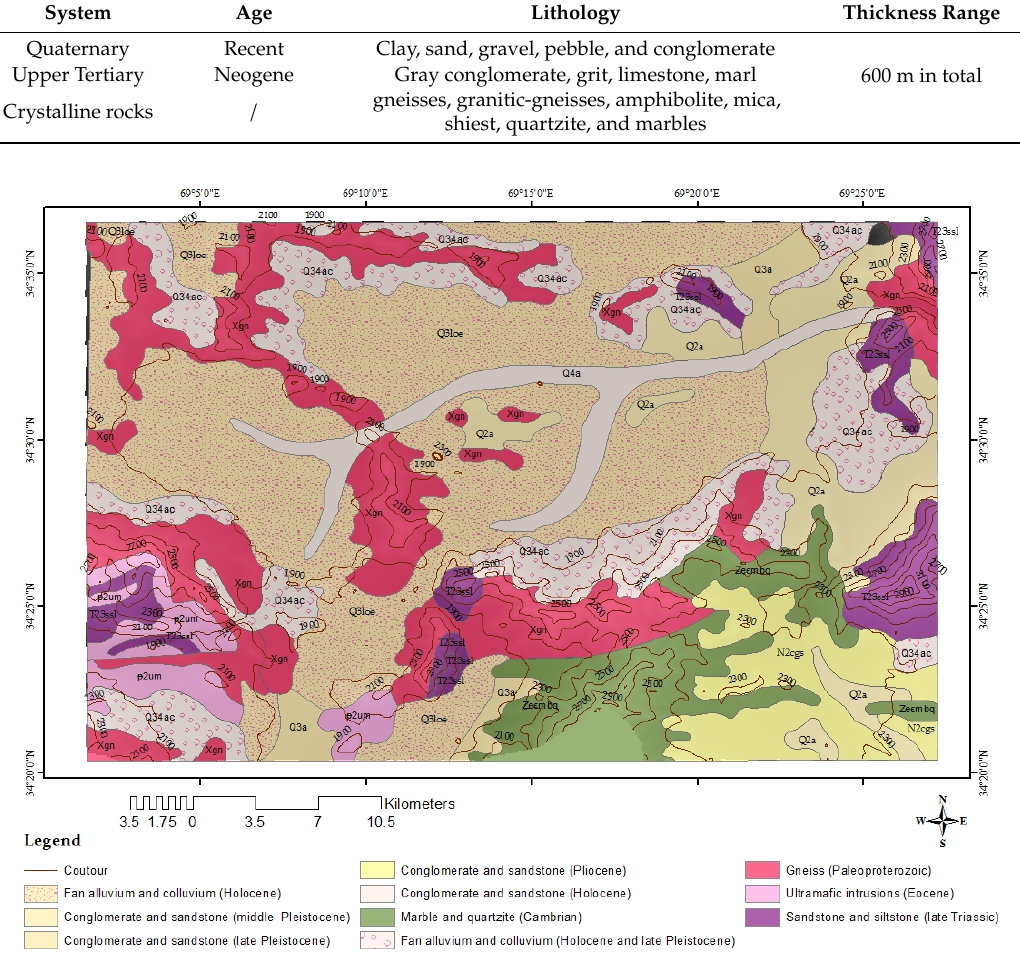
Figure 2. Geological setting of study area. This map is created based on the geological map of the whole of Afghanistan, which was prepared by the US Geological Survey (USGS).